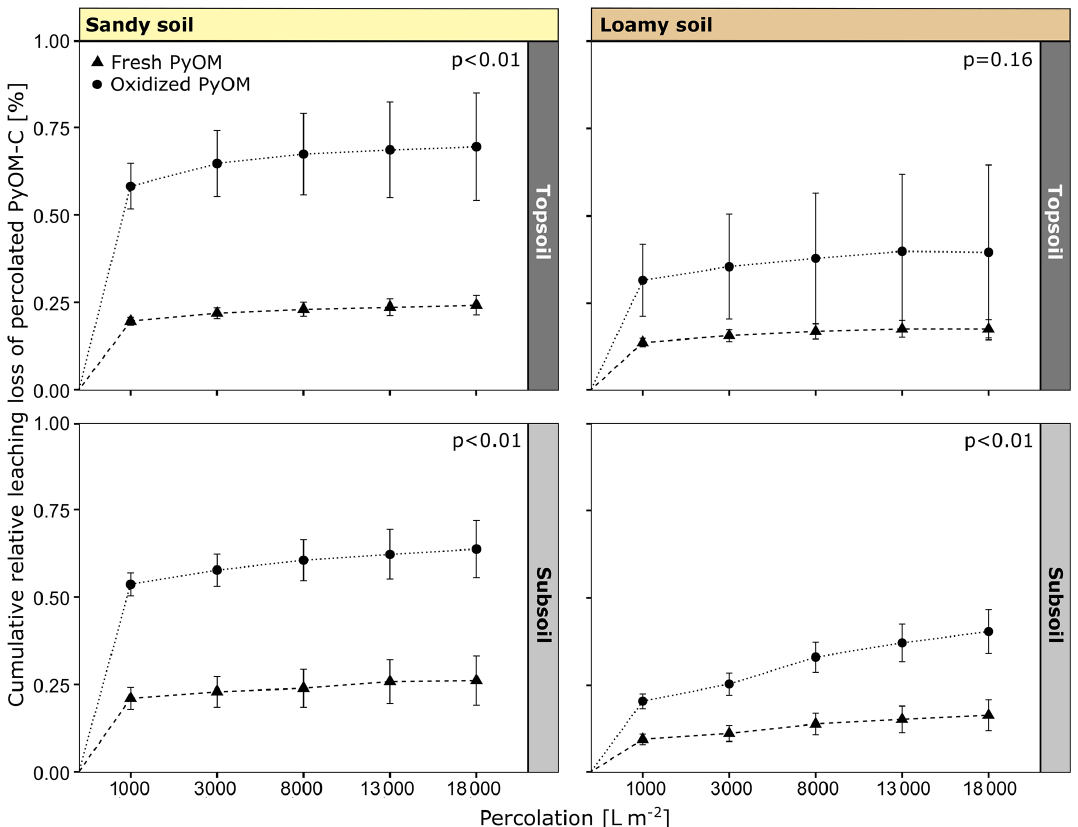
Figure 2. Cumulative leaching loss of percolated fresh and oxidized PyOM from sandy and loamy topsoil and subsoil. The p values indicate the significance of differences between fresh and oxidized PyOM after a total percolation of 18000Lm − 2 . All values are shown with propagated